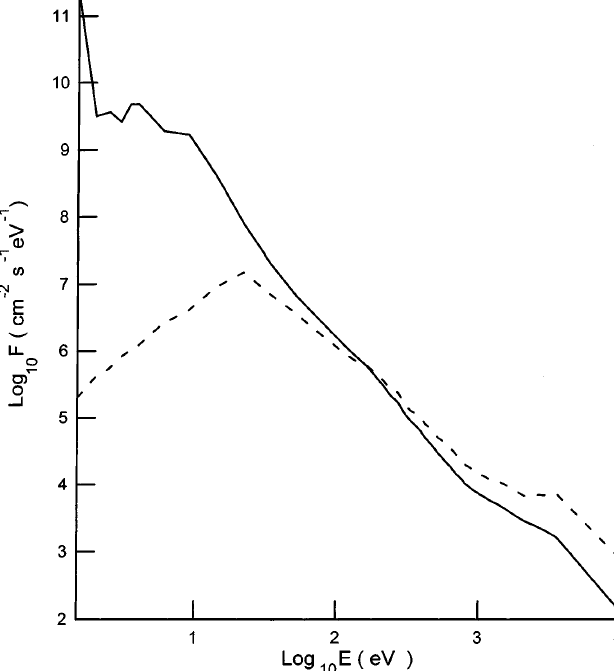
Fig. 1. The calculated flux of precipitating electrons at 300 km at 05:51:51 UT on August 4 in the SAR-arc region ( solid line ) for the incident electron flux ( dashed line )